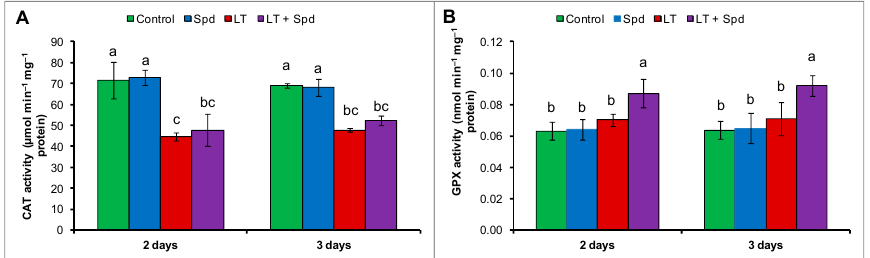
Figure 6. Activities of catalase (CAT) ( A ) and glutathione peroxidase (GPX) ( B ) in mung bean seedlings. Spd and LT indicate spermidine (0.25 mM) and low temperature (6 °C), respectively. Mean (±SE) was calculated from three replicates for each treatment. Bars with different letters are significantly different at p ≤ 0.05 applying DMRT.